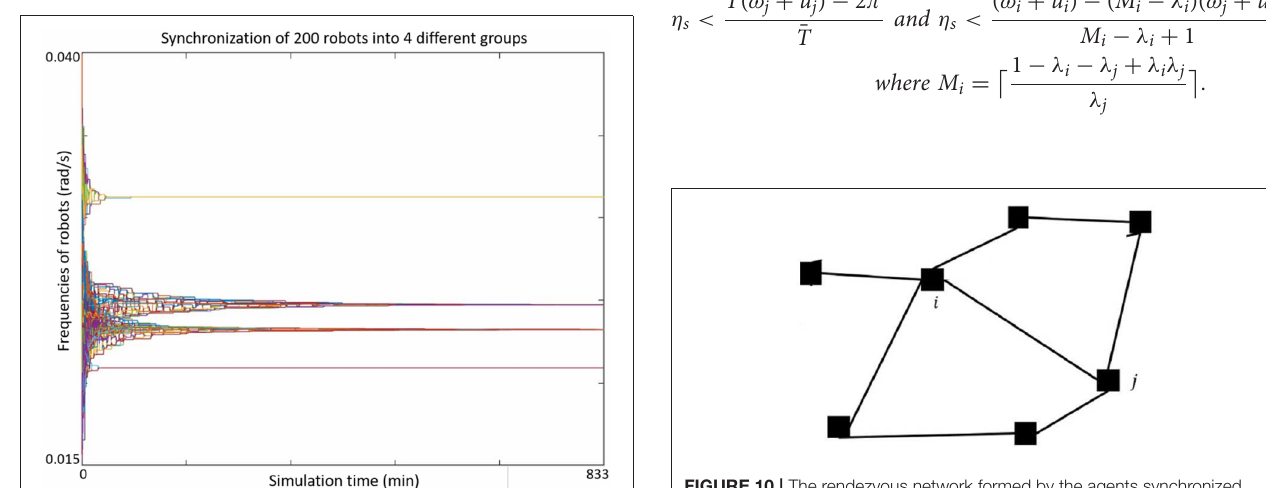
FIGURE 10 | The rendezvous network formed by the agents synchronized following the second approach. An edge means that the pair is able to rendezvous periodically with a period no longer than ¯ T